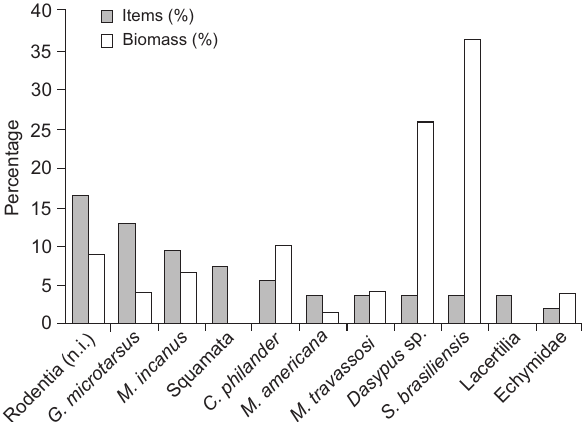
Figure 1. Percentage of total evaluated biomass and percentage of occurrence in the items found in margay’s 30 scats at Vale do Rio Doce Natural Reserve and Sooretama Biological Reserve.